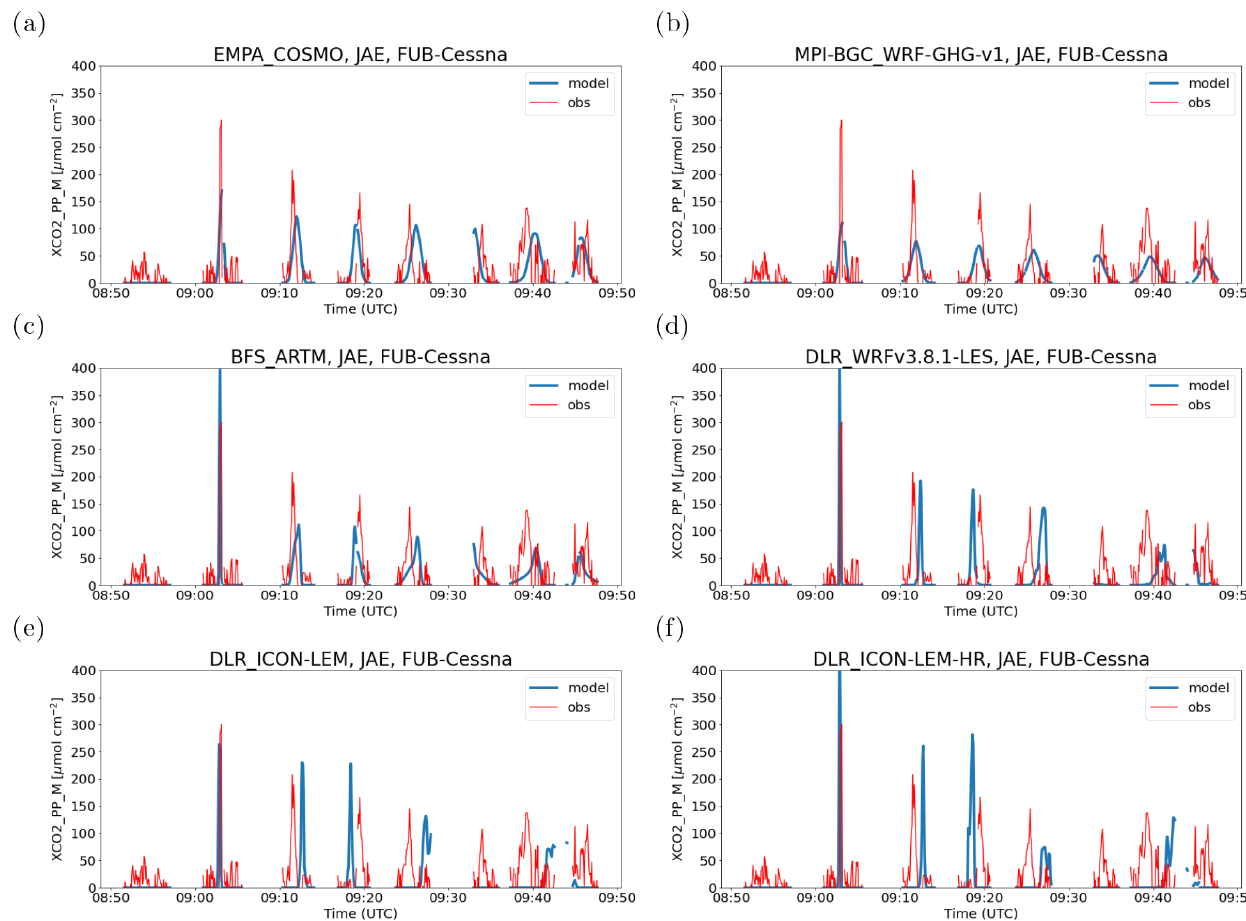
Figure 10. Time series of XCO 2 (tracer CO2_PP_M) along the FUB Cessna flight at Jänschwalde on 23 May